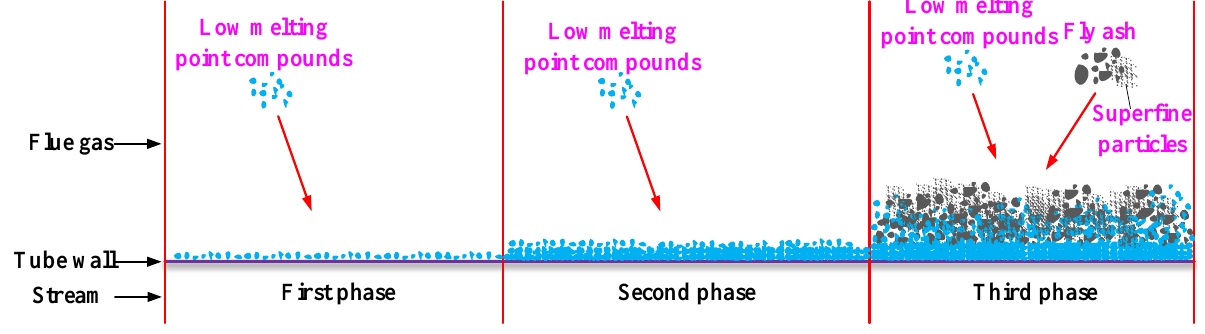
Figure 10. Diagram of the slagging